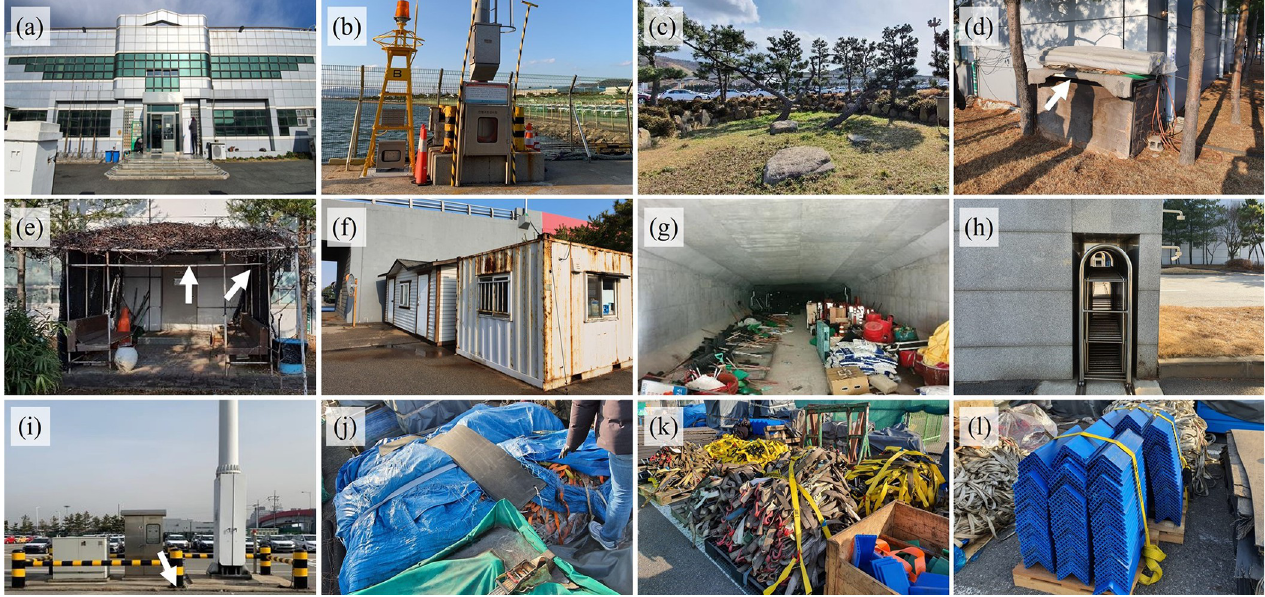
Fig 2. Representative photos of structures inspected to detect overwintering Halyomorpha halys in Ulsan and Pyeongtaek ports, Republic of Korea. (a) Building exterior (U1 in Table 2), (b) CCTV tower (U38), and (c) Stone boundary & rocky crevice (U42-45) in Ulsan port, and (d) Building appendix (P3), (e) Rest area (P4), (f) Container exterior (P7), (g) Warehouse (P12-16), (h) Gate fence (P22), (i) Light tower (P33), (j) Tarpaulin (P42), (k) Lashing (P51), and (l) Stacked plastic panels (P55) in Pyeongtaek port. White arrows indicate locations of overwintering H . halys found by visual